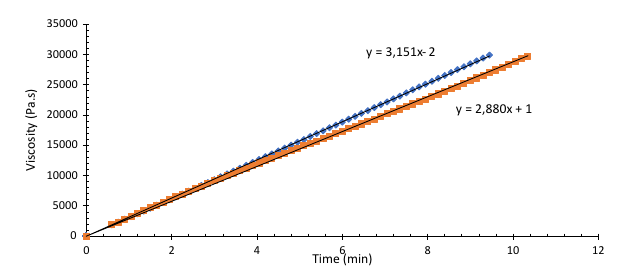
Fig. 12 Effect of temperature on polymers rheology